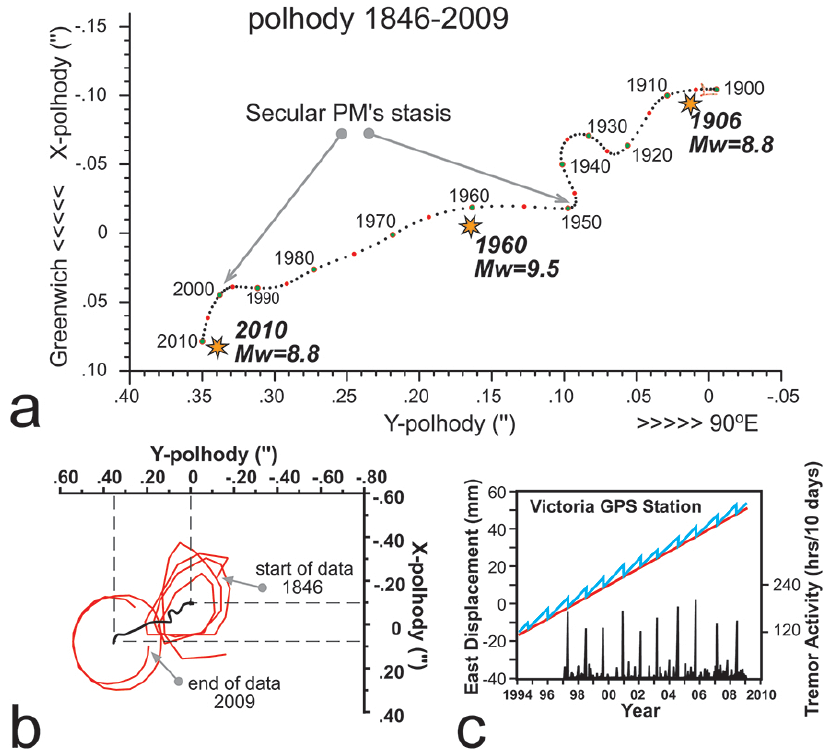
Fig. 5. (a) Oscillating path of the Secular Polar Motion starting from the earliest available data (1846). The data before 1900 exhibit an inextricable loop (in red) and they are not homogeneous with the 1900–2010 series. The three stars represent the times of the volcano- seismic correlation events along the secular PM path. The correlation events of 1960 and 2010 occur ten years after a lustrum of nearly total stasis of the PM (in 1945–1950 and 1995–2000), but this cannot be observed for the 1906 event because of the unreliability of the pre-1900 PM data. (b) Comparison between the low quality data before 1900 and higher quality modern data. The polhody (in red) a few years starting from 1846 and a few years before 2009 is fully represented beside the secular path of the centre of the polhody. Modern and oldest PM astrogeodetic data also differ in the methodology of acquisition. The radius of the PM’s spiralling (Chandler Wobble with ≈ 14 months period) fluctuates between a few meters and about 15m, while the total journey of the Secular PM is about 30m. (c) An analogous correlation (the graph is redrawn from Rubinstein et al., 2010) exists between a shorter frequency in PM (the ≈ 14 months period) and other geophysical phenomena in the North America Cascadia region – see the text for